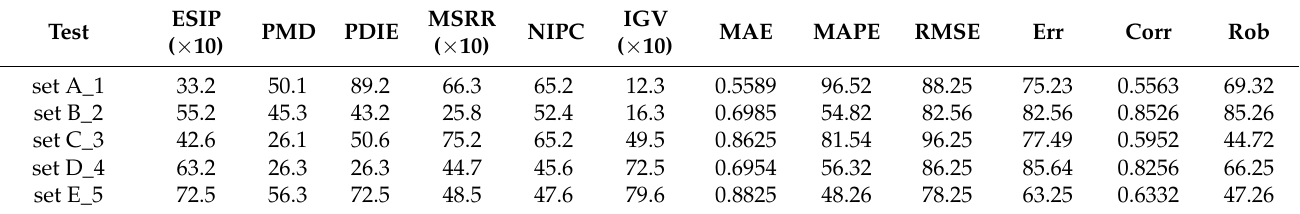
Table 10. Performance assessment of SDIQ index prediction method for different example soil